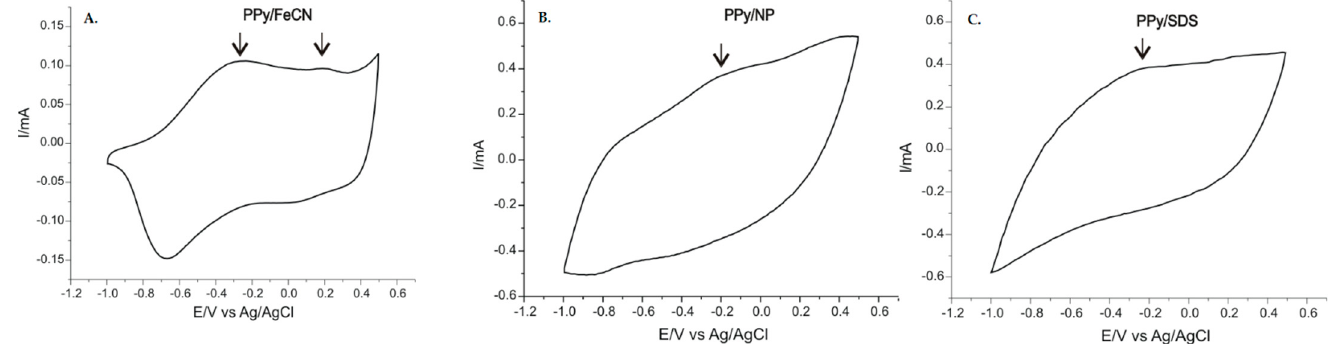
Figure 4. Responses of sensors modified with PPy immersed in a 0.1 M KCl and 10 − 3 M L-Tyr la 0.1 V × s − 1 solution: ( A ) PPy/FeCN-SPCE, ( B ) PPy/NP-SPCE, and ( C ) PPy/SDS-SPCE [27].